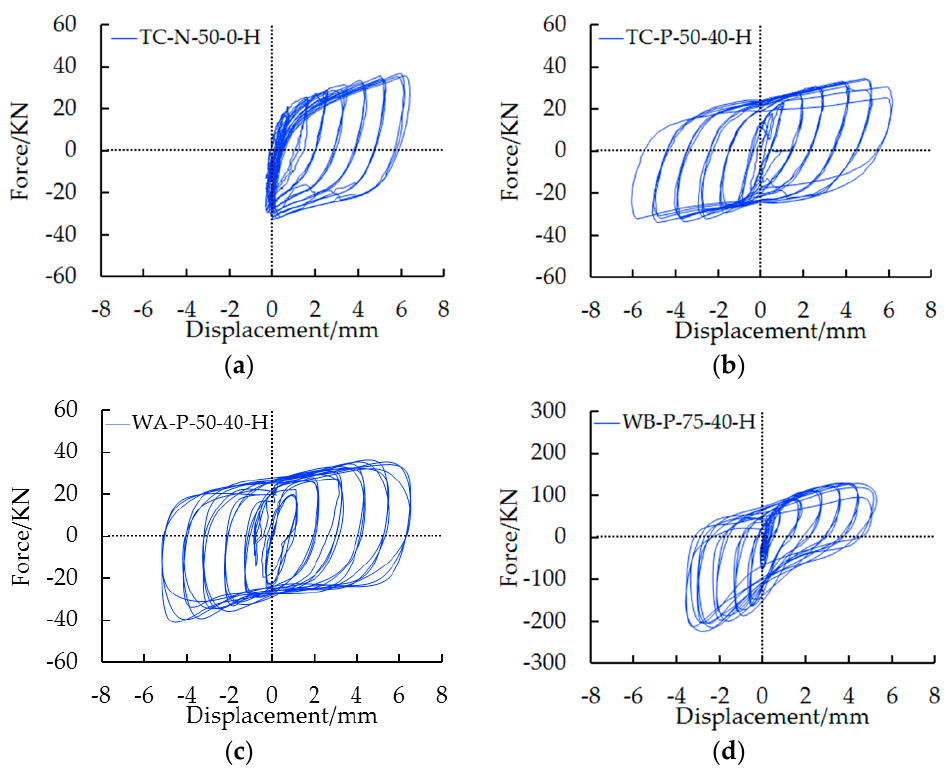
Figure 10. Relation curves between cyclic force and displacement of four representing specimens, they are ( a ) TC-P-50-0-H; ( b ) TC-P-50-40-H; ( c ) WA-P-50-40-H; ( d ) WB-P-75-40-H, coming from three groups respectively.